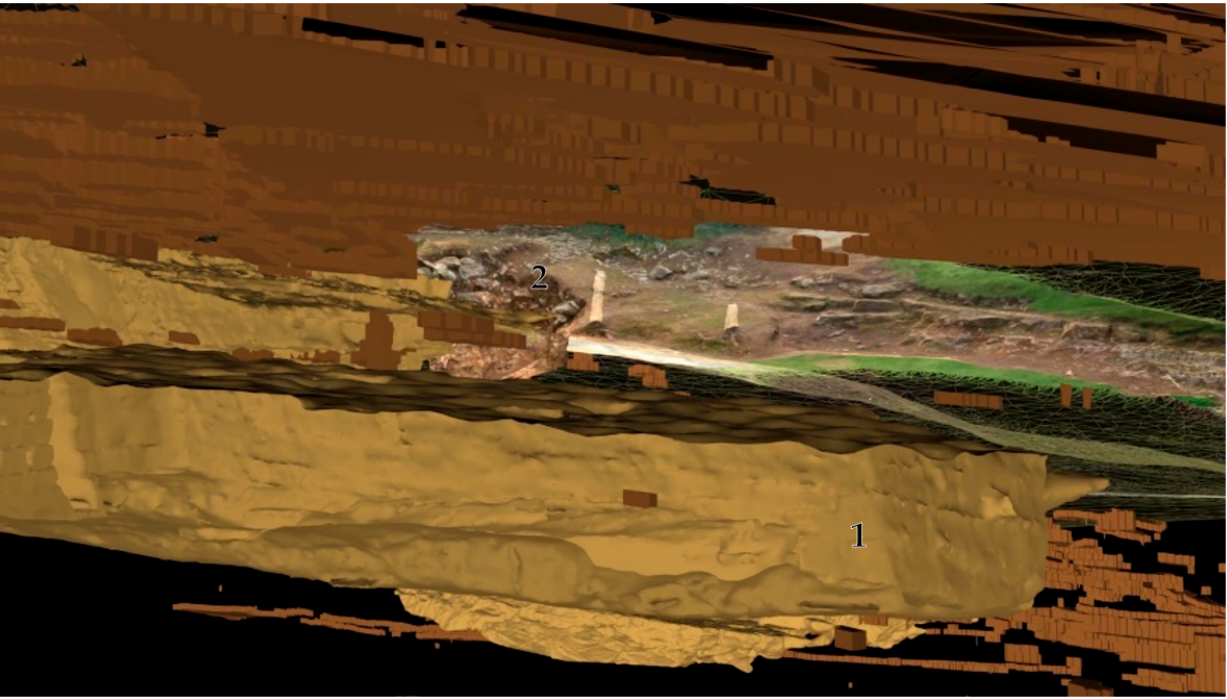
Figure 20. Video capture of integrating the UAV model, 3DTLS, and GPR (100 MHz antenna), showing discontinuities in the Polychrome Hall (1) and the exterior excavation (2).